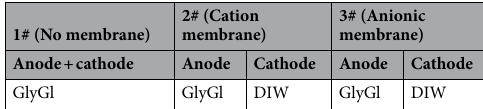
Table 1. Electrolytic experiment setup of GlyGl.